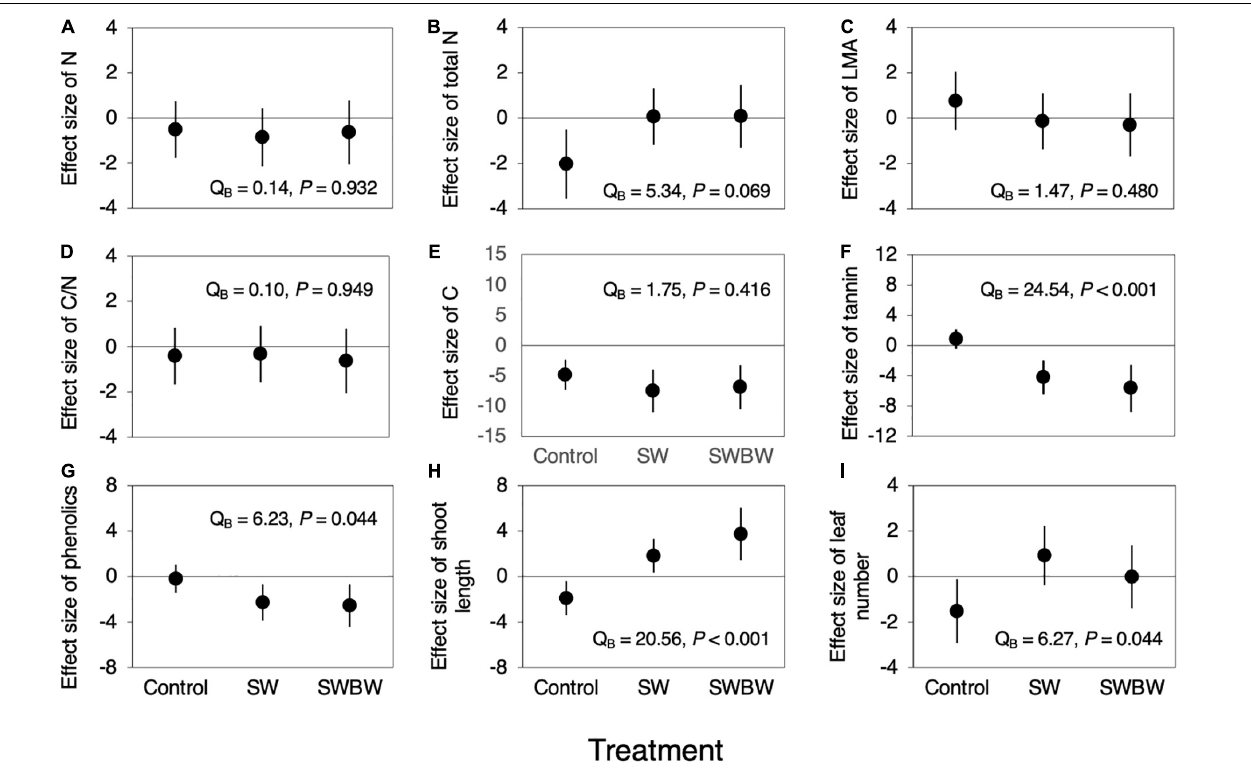
FIGURE 4 | Effect sizes (Cohen’s d ) of temporal variation (between 2010 and 2012) in leaf traits and plant growth characteristics in control trees (Control, n = 5), the soil-warmed trees (SW, n = 5), and soil and canopy branch-warmed trees (SWBW, n = 4). (A) N, (B) Total N per shoot, (C) LMA, (D) CN ratio, (E) C, (F) Condensed tannin, (G) Total phenolics, (H) Shoot growth, and (I) Number of leaves per shoot. Positive effect size indicates that leaf traits and plant growth characteristics increased from 2010 to 2012 (before and after the warming experiment). Each dot indicates mean effect size. Each vertical line denotes 95% confidence interval (CI). The effect is significant if the 95% CI does not include zero. Significant Q B value indicates between-treatment